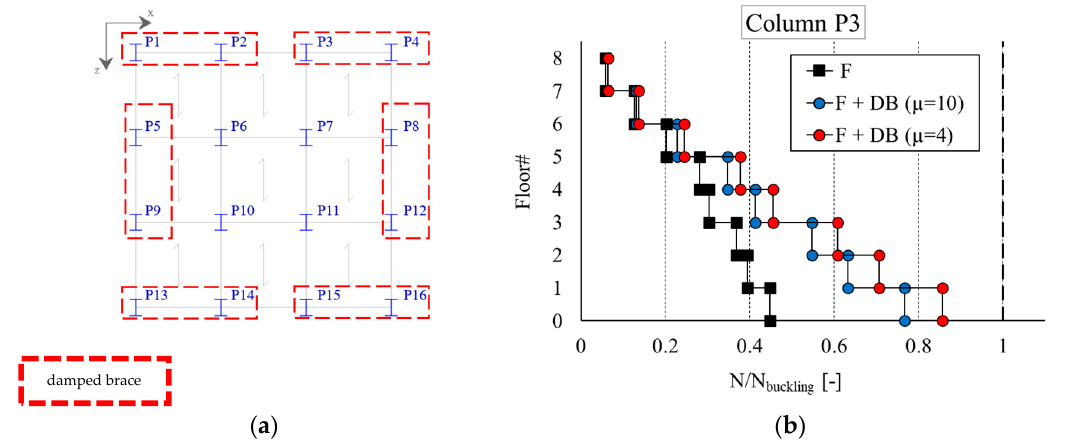
Figure 16. ( a ) new plan layout of damped braces in the eight-story MRF; ( b ) buckling checks in column P3 of the retrofitted frame.